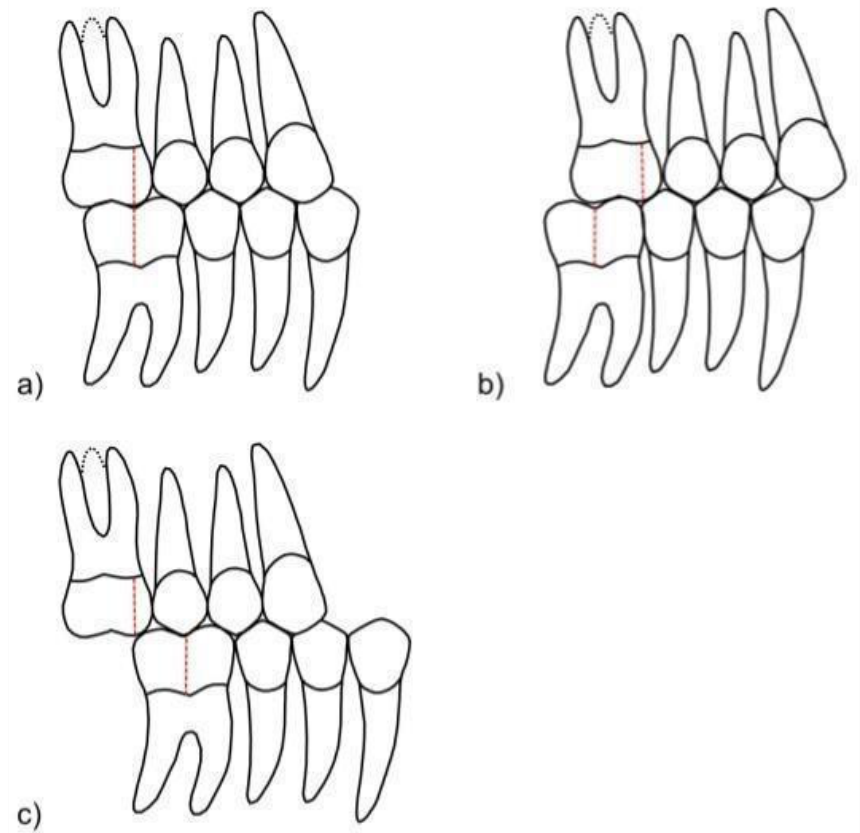
Figure 1. Schematic representation of different Angle classes: ( a ) Angle class I, ( b ) Angle class II, and ( c ) Angle class III.